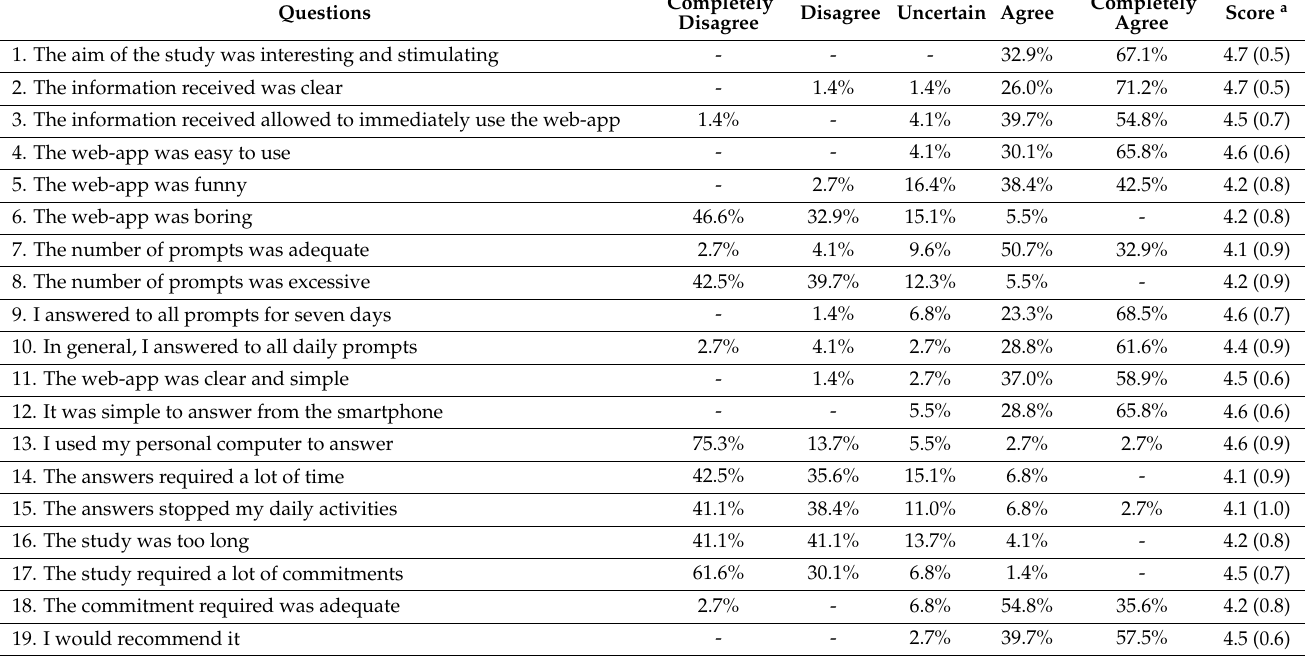
Table 2. Level of agreement with statements related to the research and to the usability of the